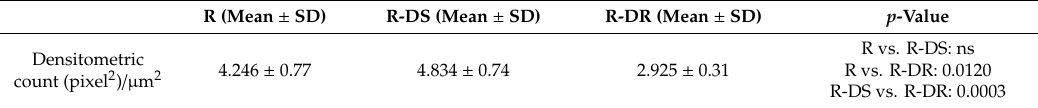
Figure 3. Histochemical evaluation of the fibrous component (collagen fibres) in the articular cartilage by Mallory’s trichrome staining through computerised densitometric measurements and image analysis. ( A ) R group; ( B ) R-DS group; ( C ) R-DR group. In inserts are the image analyses by the software in which the red colour represents blue staining (collagen fibres), showing a decreased staining in the R-DR group. For details, see the text. ( A – C ) Objective lens, 10; scale bars: 100 μ m. These are the most representative images of articular cartilage from rats of each group (R, R-DS and R-DR). Table 4. MALLORY’S Trichrome Staining—Articular cartilage.